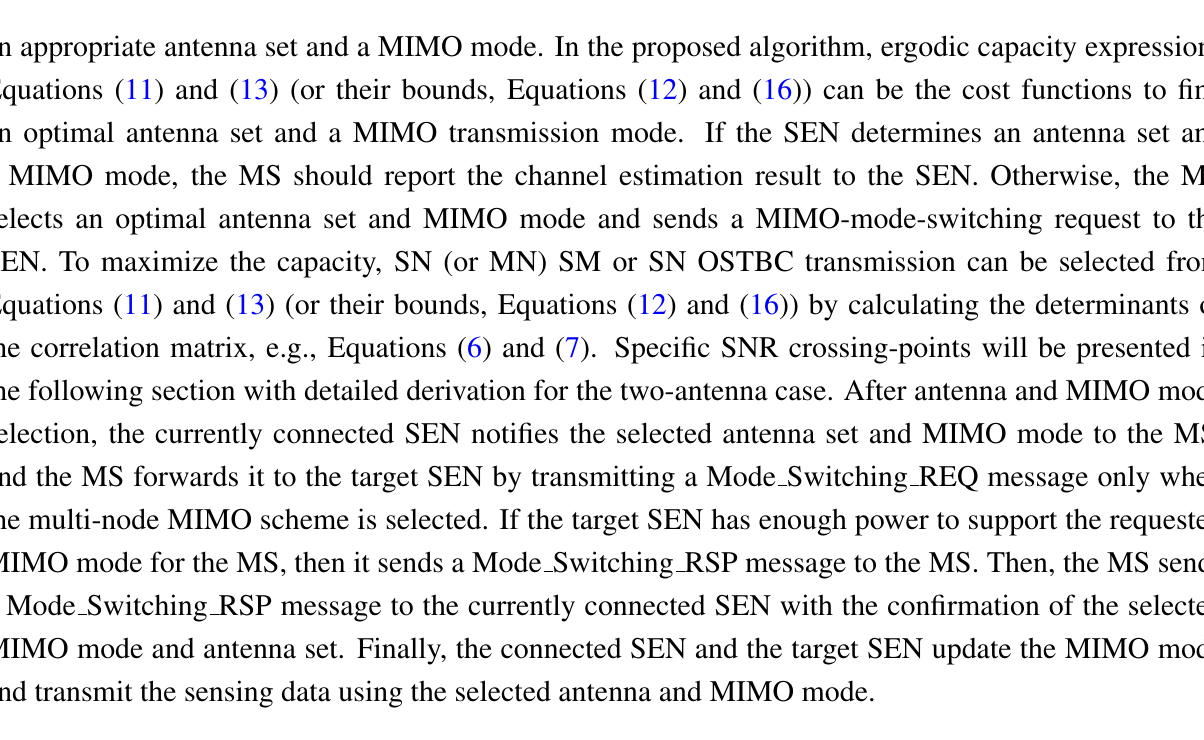
Figure 5. The procedure of a statistical multi-node MIMO